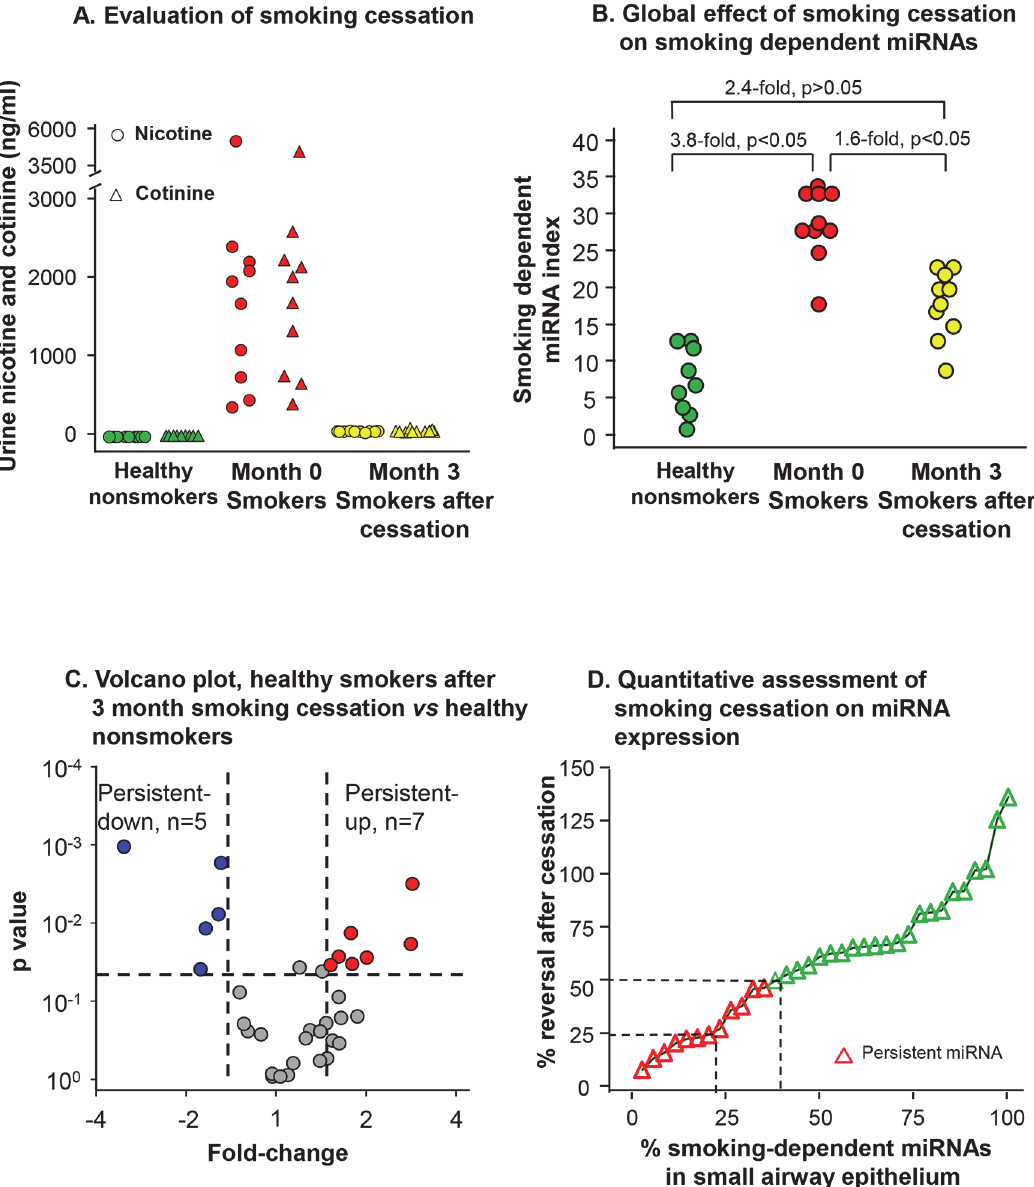
Fig 2. Effect of smoking cessation on the SAE expression of the 34 miRNAs dysregulated by smoking. A: Quantitative evaluation of smoking cessation. Urine nicotine and cotinine levels of healthy nonsmokers, healthy smoker before smoking cessation (month 0), healthy smokers after 3 months smoking cessation. B: Global effect of smoking cessation on smoking-dependent miRNAs. Smoking dependent miRNA indexes based on 34 smoking dependent miRNAs were calculated (see Methods) for each of the healthy nonsmokers, healthy smokers before smoking cessation (month 0) and healthy smokers after 3 months smoking cessation. C: Volcano plot of the 34 smoking-dependent miRNAs in healthy smokers after 3-month smoking cessation compared to healthy nonsmokers. X-axis, fold-change, healthy smokers after 3-month smoking cessation vs healthy nonsmokers; Y-axis, p value. Twelve of the 34 miRNAs were not reversed after smoking cessation (criteria p < 0.05, fold-change > 1.5). D: Quantitative assessment of smoking cessation on miRNA expression in human SAE. Using mean absolute expression levels, the degree of reversibility in a miRNA was calculated as: % change = [(healthy smokers before smoking cessation — healthy smokers after 3-month smoking cessation)x100 / (healthy smokers before smoking cessation — healthy nonsmokers)]. X-axis — percentage of the smoking dependent miRNA (in order of ascending % change). The persistent miRNA identified in panel C are shown as red. Y-axis — % change of miRNA. The vertical dash line indicates the percentage of miRNAs which have 25% and 50% reversal.